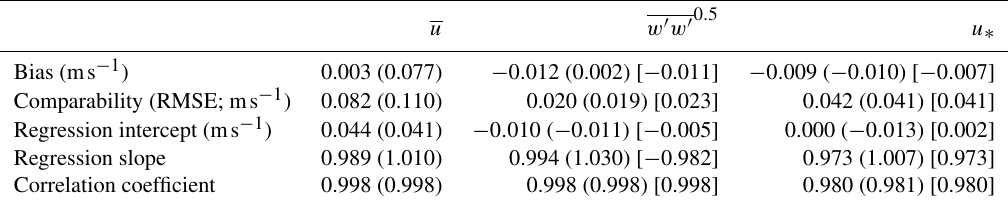
Figure 4. Meteorological conditions during the intercomparison experiment based on 10min data from the nearby weather station (ID 662, 52.2915 ◦ N, 10.4464 ◦ E, 81ma . s . l . ) of the German Weather Service (DWD). Data were provided by the DWD Climate Data Center (CDC). Table 1. Statistical quantities characterizing the differences between the measurements of the CSAT3B sonic anemometer and the PTB bistatic Doppler lidar, based on 458 paired observations of turbulence statistics, each averaged over 30min. The statistics for the CSAT3B data after applying the H15 correction are shown in round brackets. The statistics without application of a low-pass filtering correction to either of the instruments are shown in square brackets ( u is not